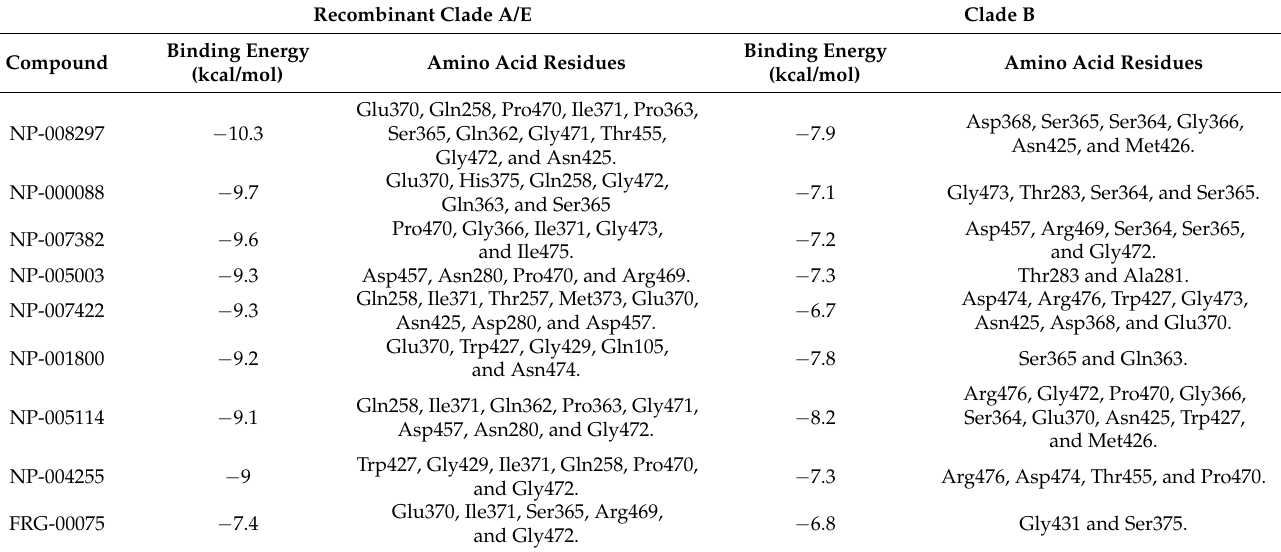
Table 2. Binding energies and interacting amino acid residues of recombinant clade A/E and clade B HIV-1 gp120.